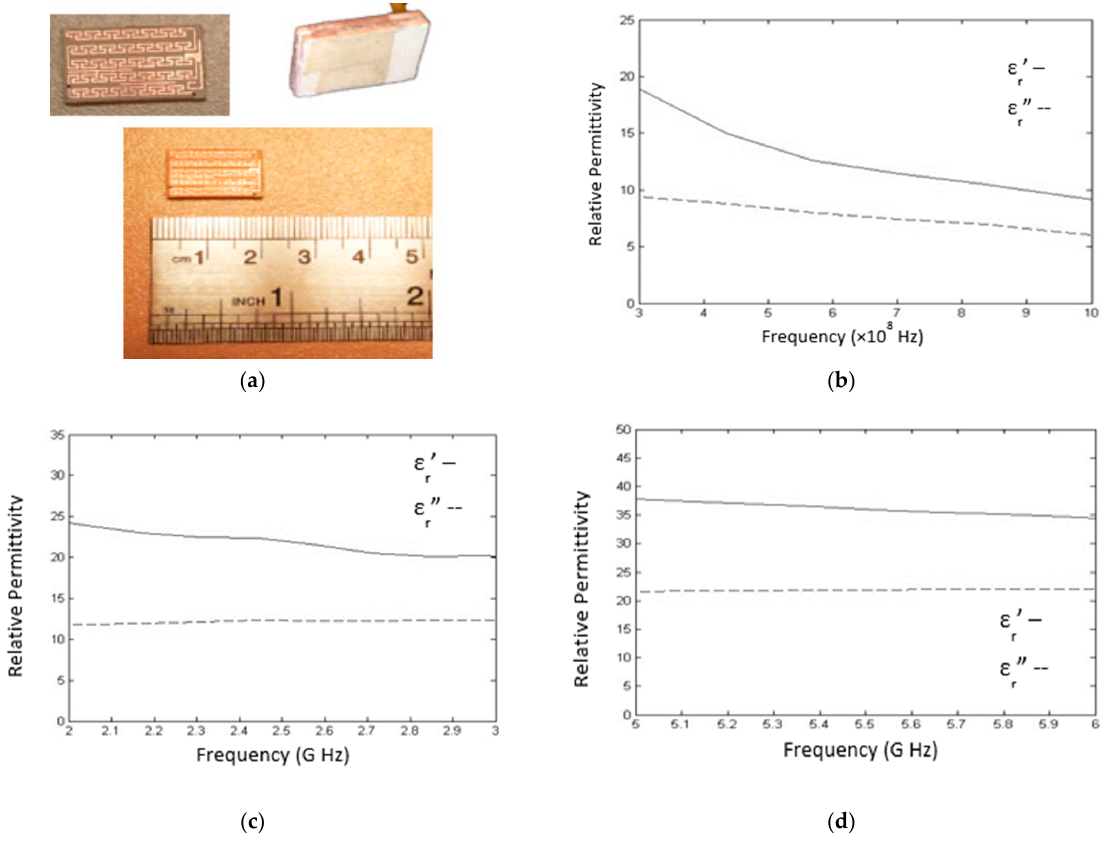
Figure 7. ( a ) Fabricated structure of the antenna with and without superstrate. ( b – d ) Measurement of the relative permittivity of equivalent phantoms at the three